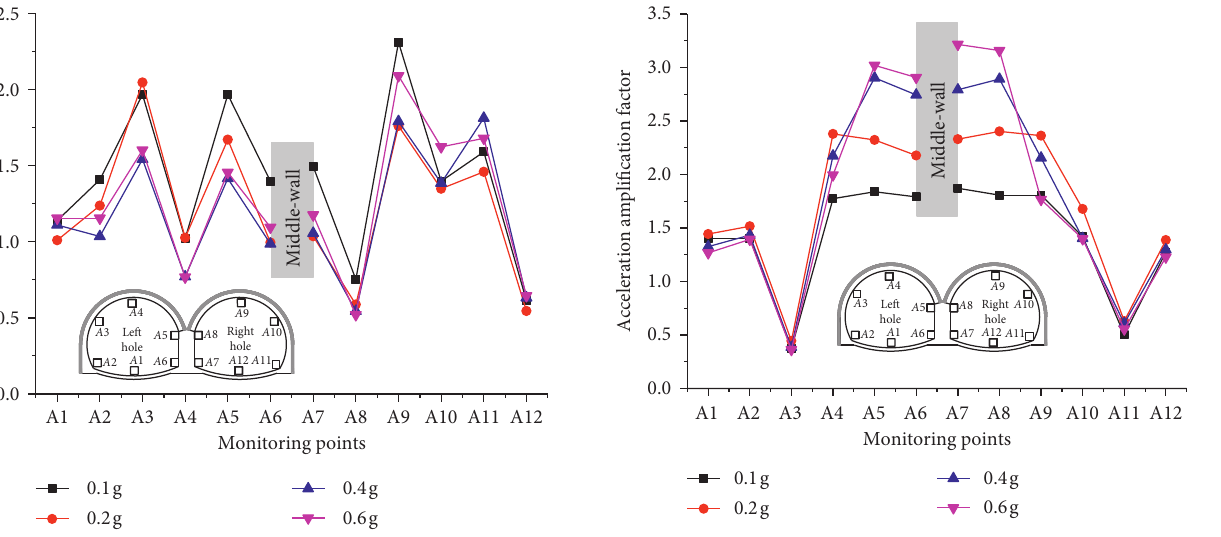
Figure 10: Variation trends of AAF of WC-XZ in the X